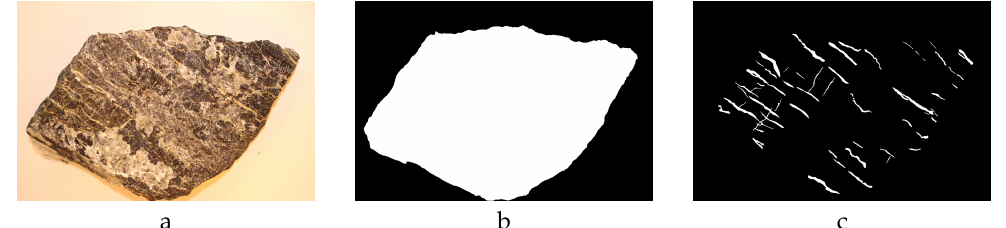
Figure 4. The typical image ( a ) and labelled mask of alone rock chunks boundaries ( b ) and veins ( c ) for the dataset № 1.